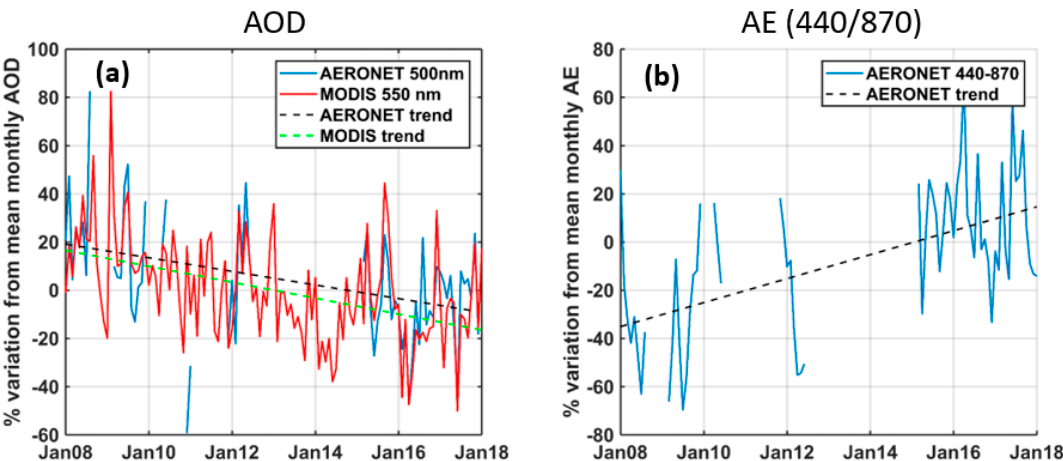
Figure 6. De-seasonalized trends, derived from monthly averaged ( a ) AOD 500 and ( b ) AE coefficient, for the time period 2008–2017. The corresponding AOD values and trend derived by MODIS are also shown in ( a ).